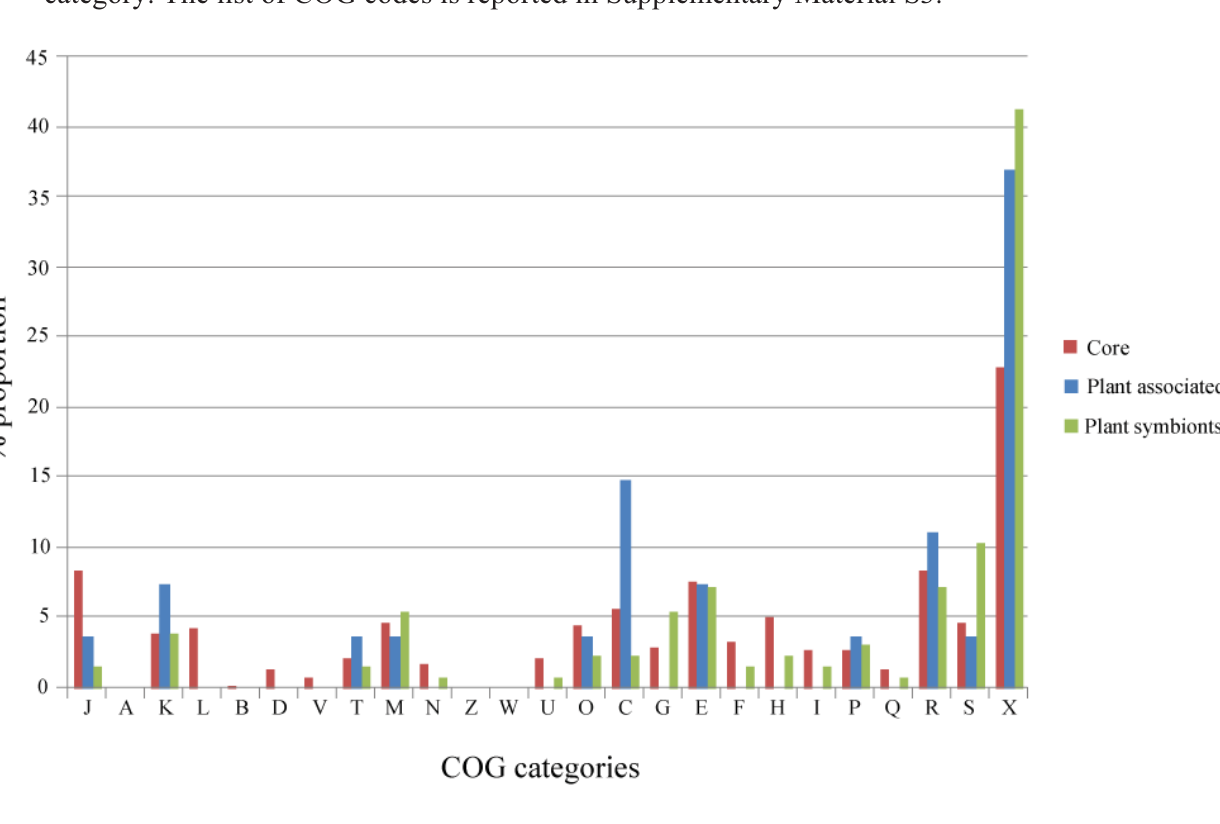
Figure 3. Percent distribution of orthologous groups belonging to the different subsets (Core, Plant-Associated and Plant symbionts) among Cluster of Orthologous Groups (COG) categories. Note that each orthologous group can be mapped to more than one category. The list of COG codes is reported in Supplementary Material